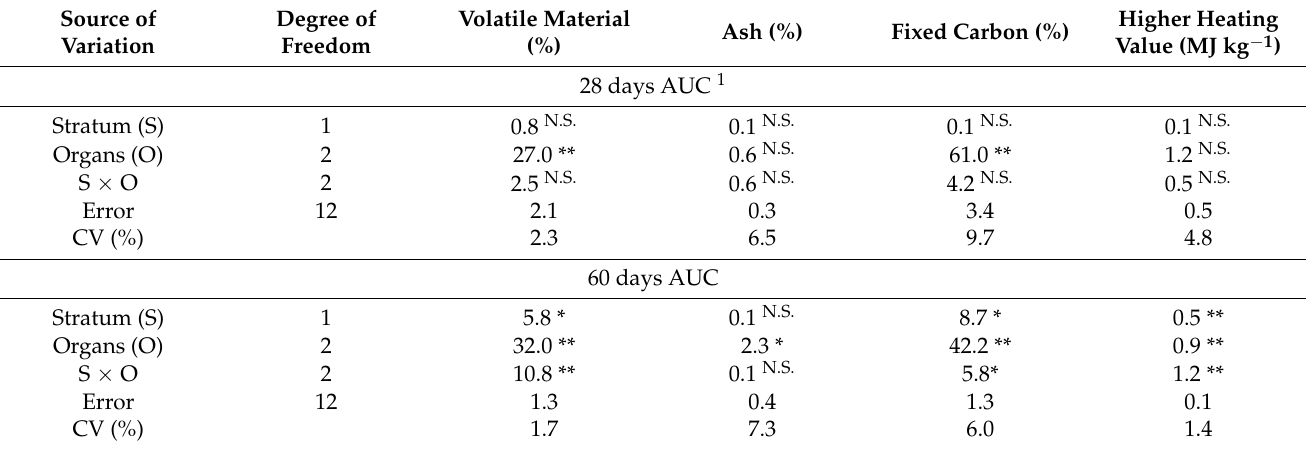
Table 1. Analysis of variance of proximal biomass analyses results for different strata and organs of